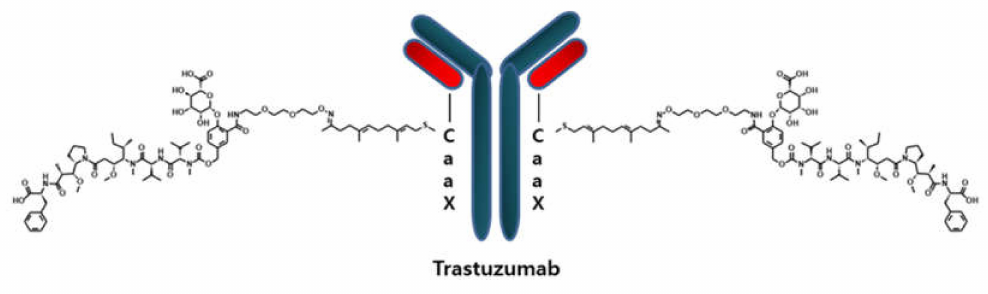
Figure 6. Structure of LCB14-0110